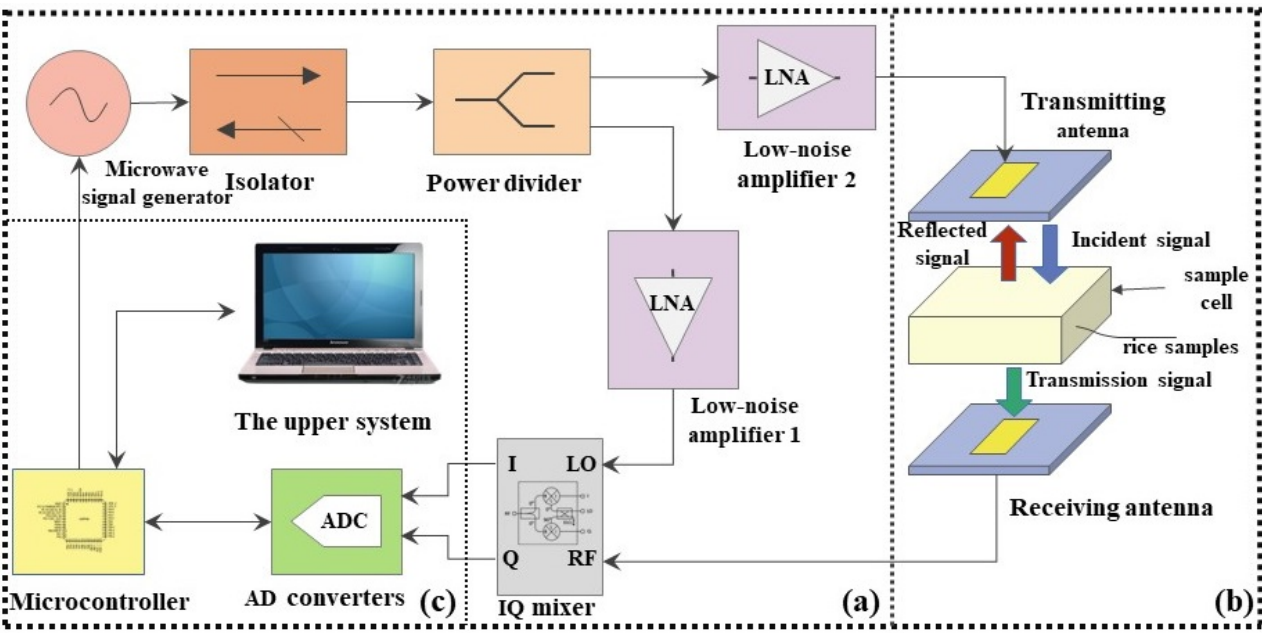
Figure 2. Schematic diagram of detection device: ( a ) a microwave signal transmission-generation module; ( b ) a real-time measurement module; ( c ) a signal receiving-processing module.